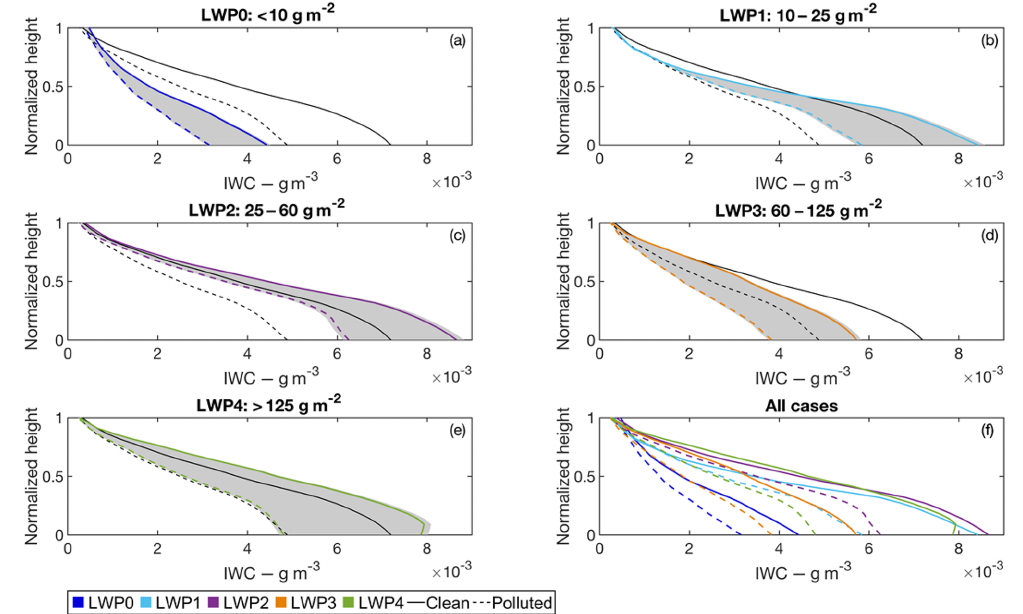
Figure 2. Vertical profiles of ice water content for clean and polluted conditions, as in Fig. 1, for (a) LWP0, (b) LWP1, (c) LWP2, (d) LWP3, (e) LWP4 and (f) all LWP bins. The black reference lines represent the mean profiles for all the LWP bins. Grey shading represents regions of the cloud layer where there is a statistically significant difference between the clean and polluted IWC